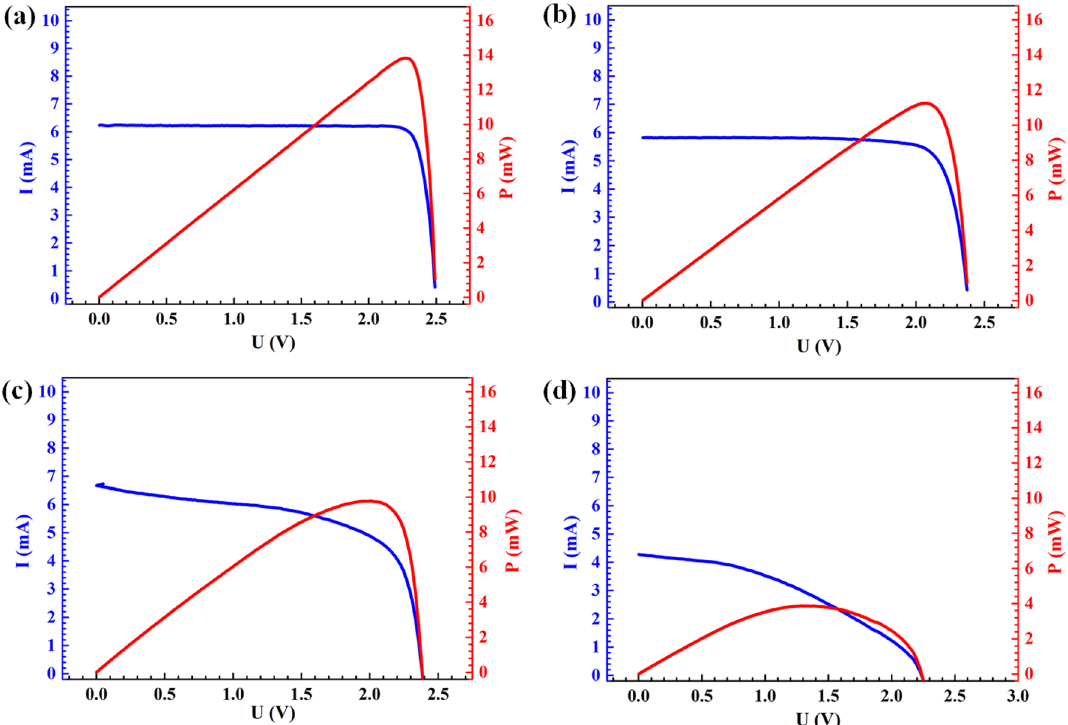
Figure 3. Electrical outputs of ( a ) an intact PV cell, and damaged PV cells impacted by massive particles with ( b ) N 1 = 35/mm 2 , v i = 100 m/s (i.e. corresponding to No.3 in Table 1), ( c ) N 2 = 80/mm 2 , v i = 135 m/s (i.e. corresponding to No.6 in Table 1), ( d ) N 3 = 150/mm 2 , v i = 150 m/s (i.e. corresponding to No.8 in Table 1). The I-V curves are tested by Keithley 2400 source meter under the illumination of AM 1.5, 100 mW/cm 2 by an Ivtest Station 4000AAA solar simulator.